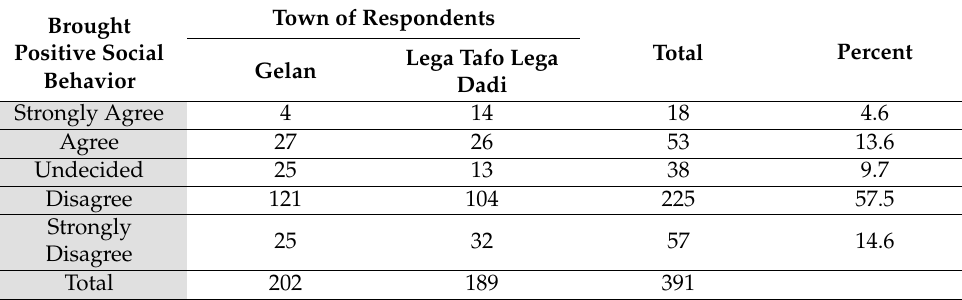
Table 3. The response rates of respondents on the social behavior of the land